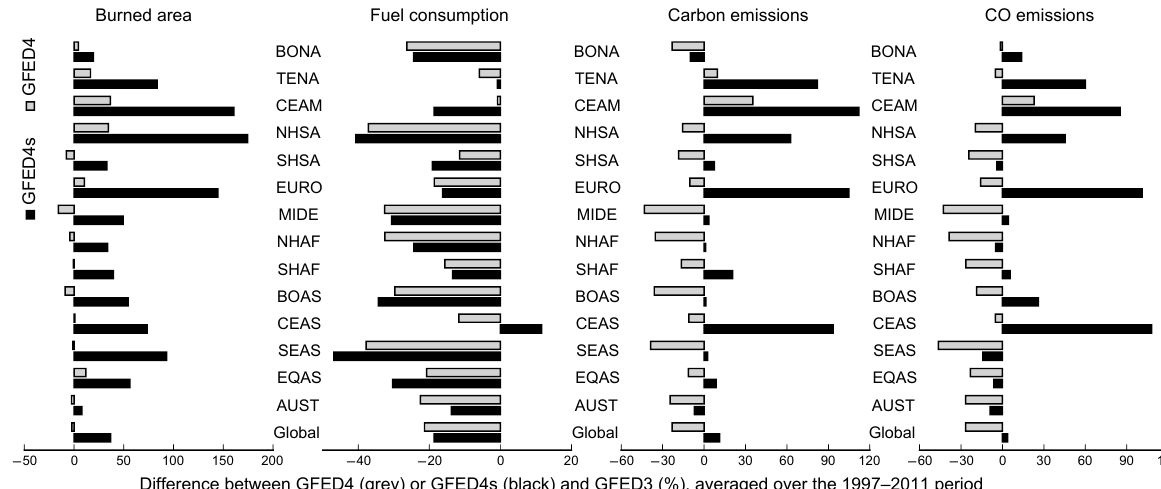
Figure 13. Relative differences in burned area, fuel consumption per unit burned area, carbon emissions, and carbon monoxide (CO) emissions between GFED4 (black) and GFED4s (grey) compared to GFED3 for 14 basis regions explained in Fig. 3 and the globe averaged over 1997 to 2011.